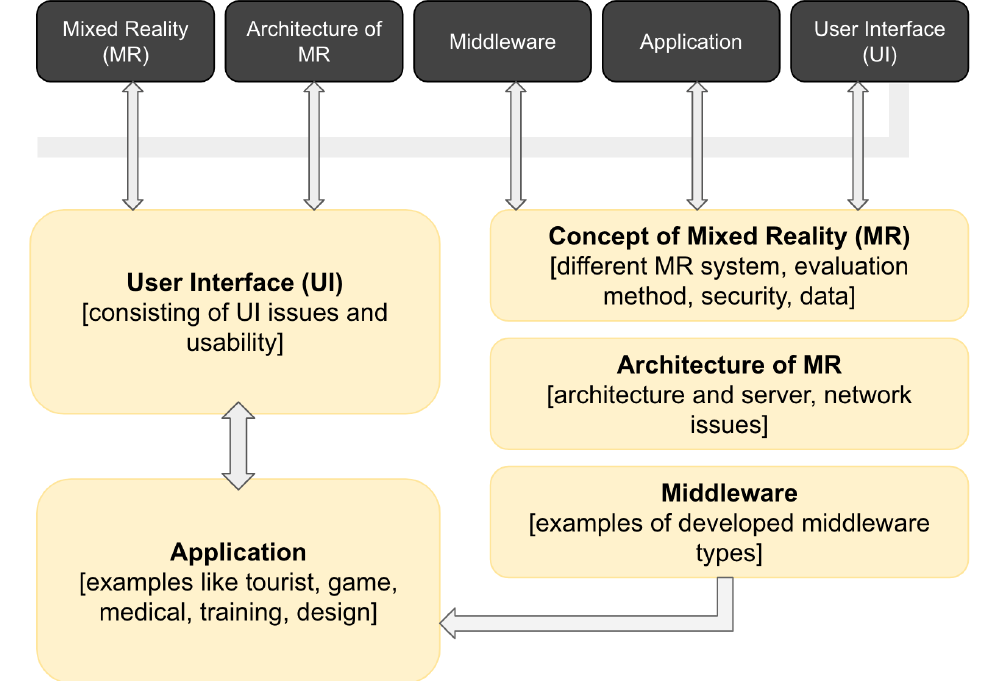
Figure 2. A comprehensive framework for mixed reality (MR) applications: the first layer describes the components of MR applications; the second and third layers are about the architecture used to integrate these components; and the final layers include the application and UI layers